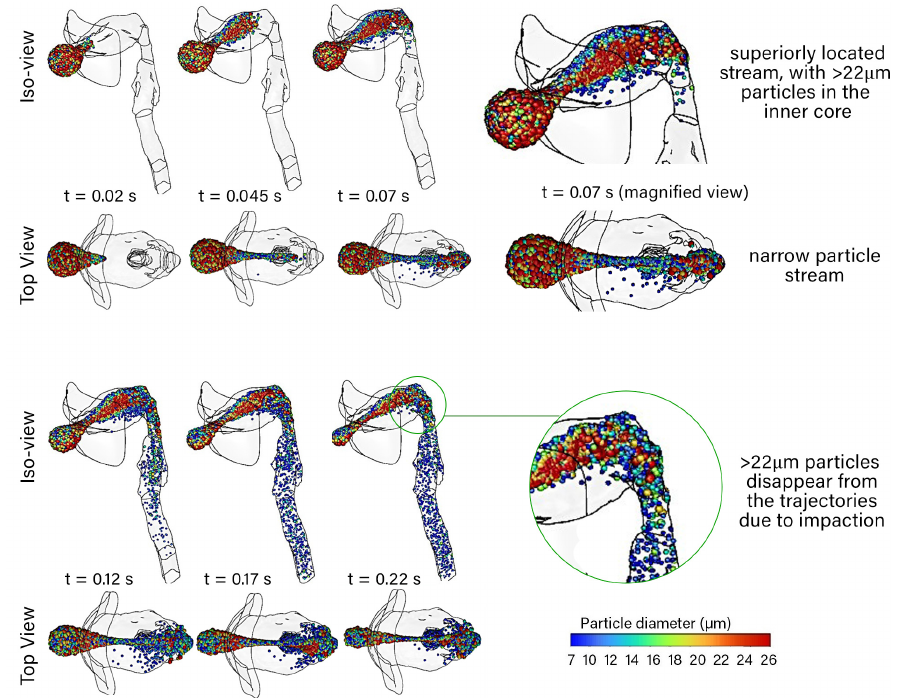
Figure 3. Isometric and top view of the mouth–throat showing the particle trajectories at three time increments from the start of the initial particle release at t = 0 s to t = 0.22 s. The particles are colored by diameter in microns.